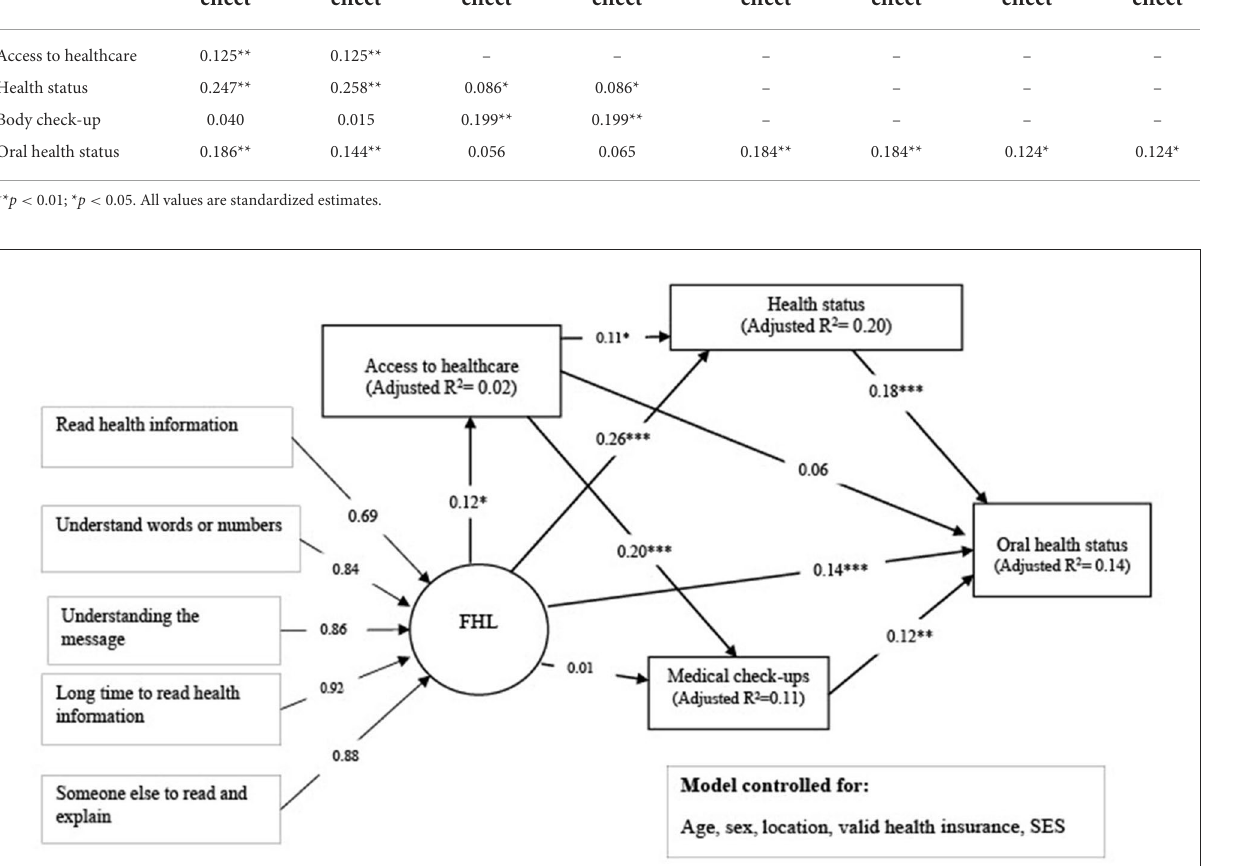
could cause periodontal diseases, such as diabetes